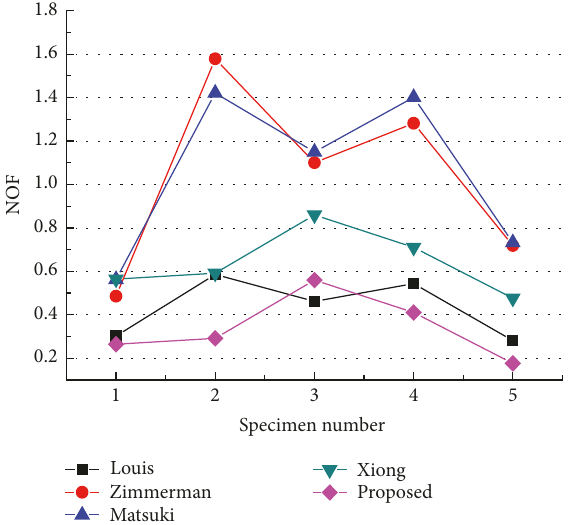
Figure 13: Normalized hydraulic aperture as a function of contact ratio 𝑐 and fractal dimension 𝐷 V .